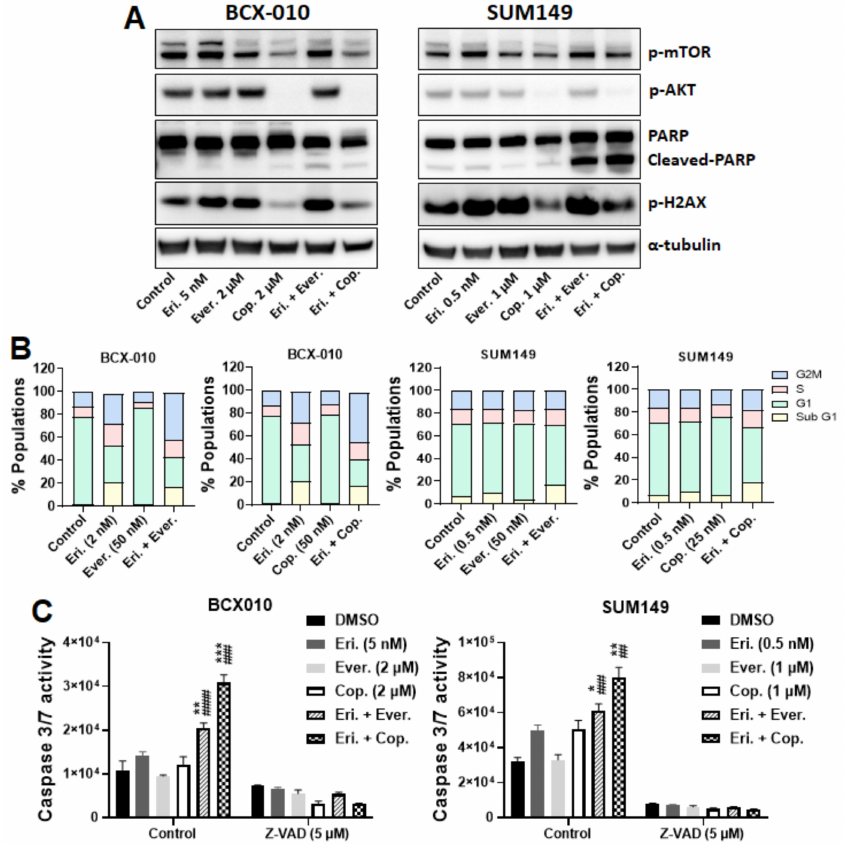
Figure 5. Eribulin synergizes with everolimus or copanlisib by arresting cell cycle progression and inducing apoptosis. ( A ) Cells were treated with eribulin alone, everolimus alone, copanlisib alone, eribulin plus everolimus, or eribulin plus copanlisib for 24 h. Following treatment, proteins were extracted and subjected to Western blotting analysis. Anti– α -tubulin was used as a loading control. ( B ) Cells were treated with eribulin alone, everolimus alone, copanlisib alone, eribulin plus everolimus, or eribulin plus copanlisib for 72 h. Following treatment, the cells were fixed in 70% EtOH, stained with propidium iodide, and subjected to flow cytometry analysis. ( C ) Cells were treated with DMSO or Z-VAD-FMK for 1 h and then with eribulin alone, everolimus alone, copanlisib alone, eribulin plus everolimus, or eribulin plus copanlisib for 24 h. Caspase 3/7 activity was determined using the Caspase-Glo 3/7 reagent. Data are presented as mean ± standard deviation. Statistical significance was assessed by two-tailed Student t -test. *, p < 0.05; **, p < 0.01; ***, p < 0.001. * indicates differences between the cells treated with eribulin alone and those treated with the eribulin-based combinations. ## , p < 0.01; ### , p < 0.001, #### , p < 0.0001. # indicates differences between the cells treated with a kinase inhibitor alone and those given the combination with eribulin. Eri., eribulin; Ever., everolimus; Cop.,